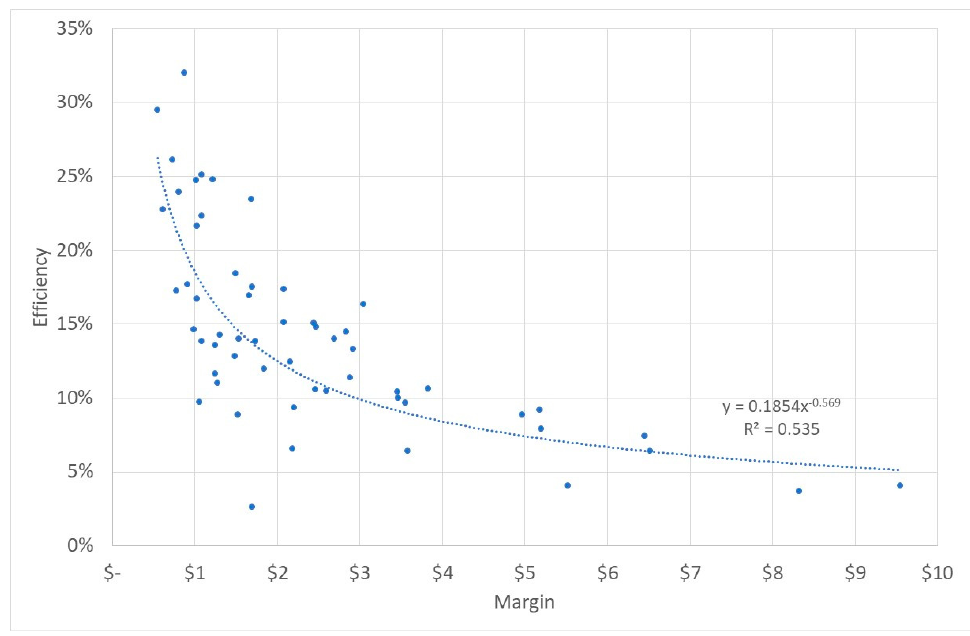
Figure 8. Margin and efficiency. Source: own.